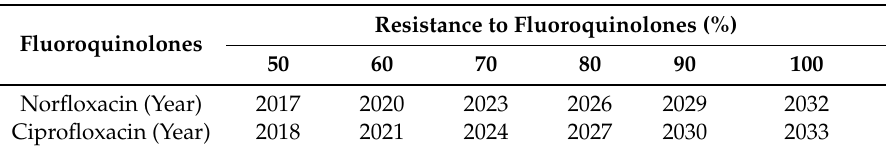
Figure 3. Percentage of resistant patient-derived E. coli samples over the six-year study period for each antibiotic assessed and Pearson’s correlation of resistant samples over time: ( A ) ampicillin + sulbactam, ( B ) cephalothin, ( C ) ciprofloxacin, ( D ) norfloxacin, and ( E ) nitrofurantoin. * p < 0.05; ** p < 0.005. Table 3. Estimation of the total resistance to Fluoroquinolones in Brazil based on the empirical treatment of patients with urinary